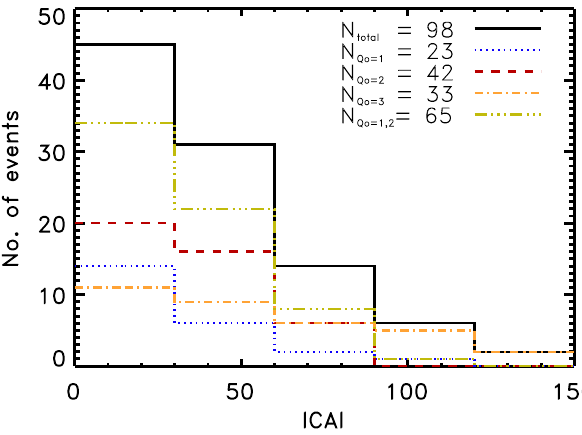
Fig. 1. Histograms of | CA | ( ≡| Y O | / R O | (in %)), for various quality ( Q O ) subsets from WIND data, over the period from early 1995 to April 2006, confirming that there is a relatively severe drop off of identified MCs as a function of | CA |